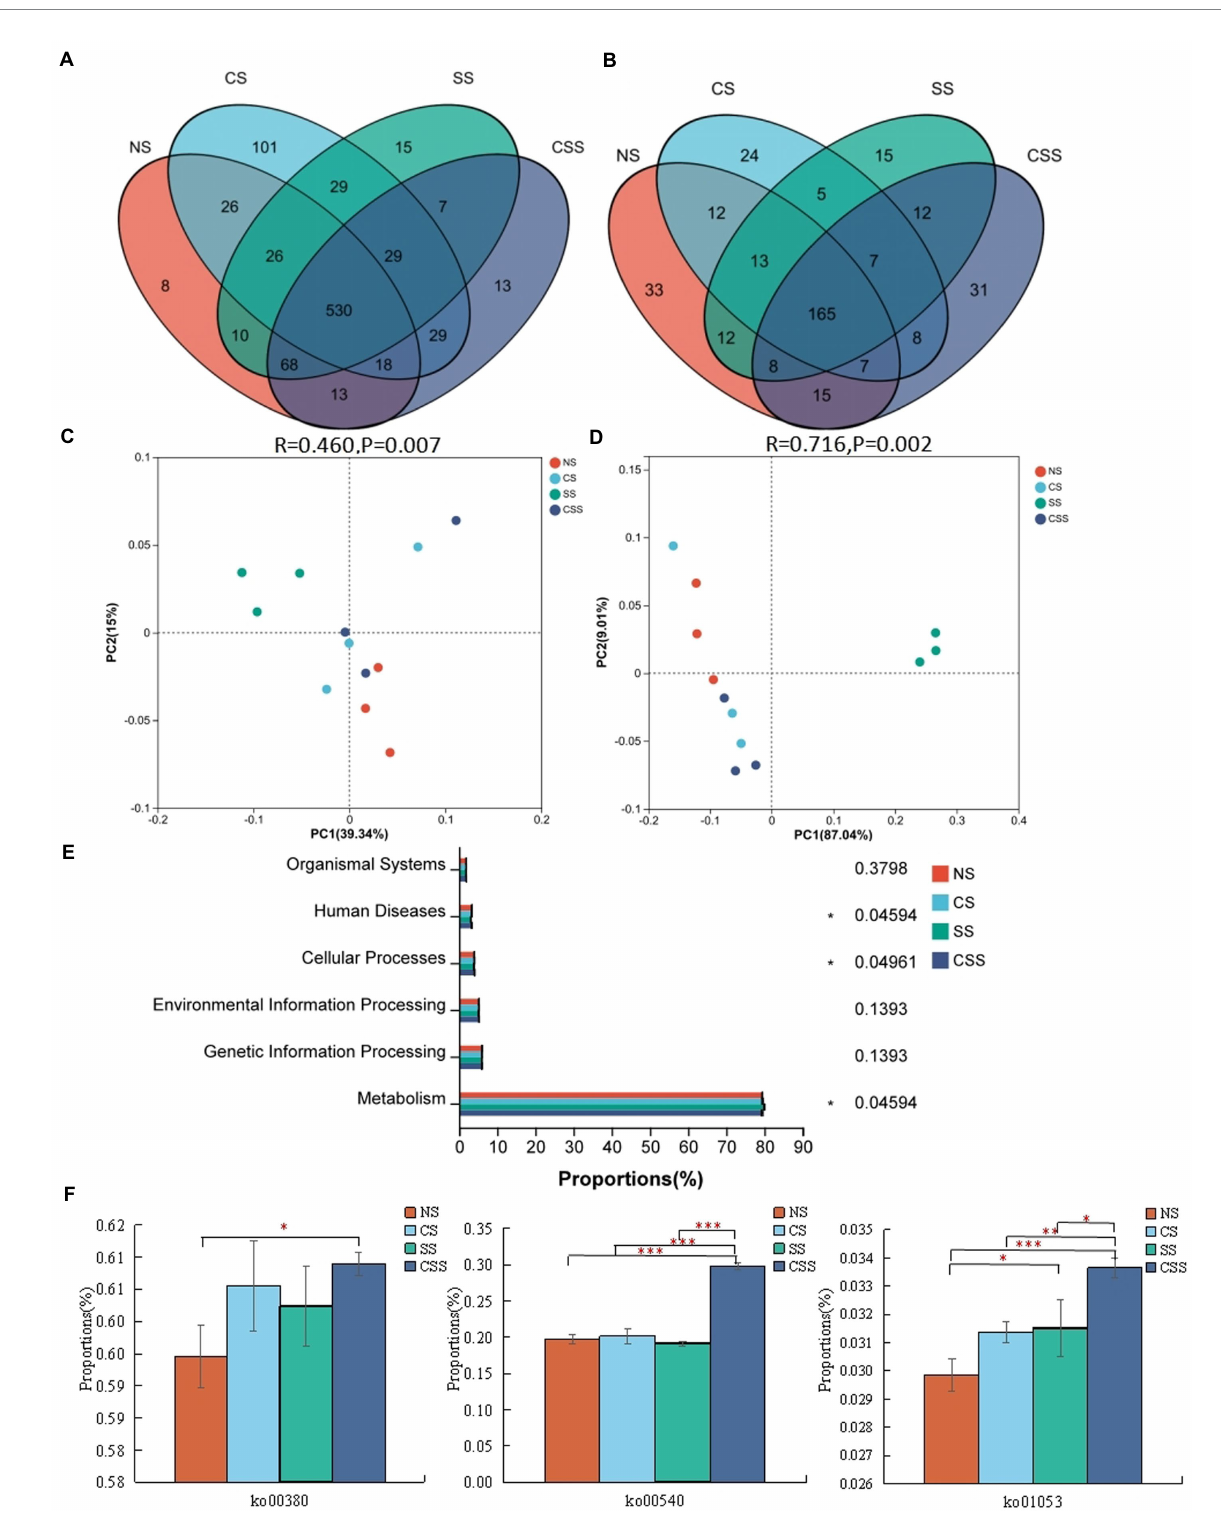
FIGURE 7 Comparative analysis and Functional analysis of peanut rhizosphere soil microbial community. (A) Venn analysis of soil bacterial composition at the genus level. (B) Venn analysis of soil fungal composition at the genus level; (C) Principal coordinate analysis (PCoA) plot showing bacteria community structure variation between the samples. (D) PCoA plot showing variation in fungal community structure among the samples; each symbol represents a sample, and the closer the two sample points, the more similar the species composition of the two samples; (E) The functional composition and relative abundance of bacteria in the primary functional layer based on the Kyoto Encyclopedia of Genes and Genomes (KEGG) pathway. The right axis is the p- value (* p < 0.05); (F) Function analysis of bacteria in the third functional layer based on the KEGG pathway; ko00380: tryptophan metabolism; ko00540: